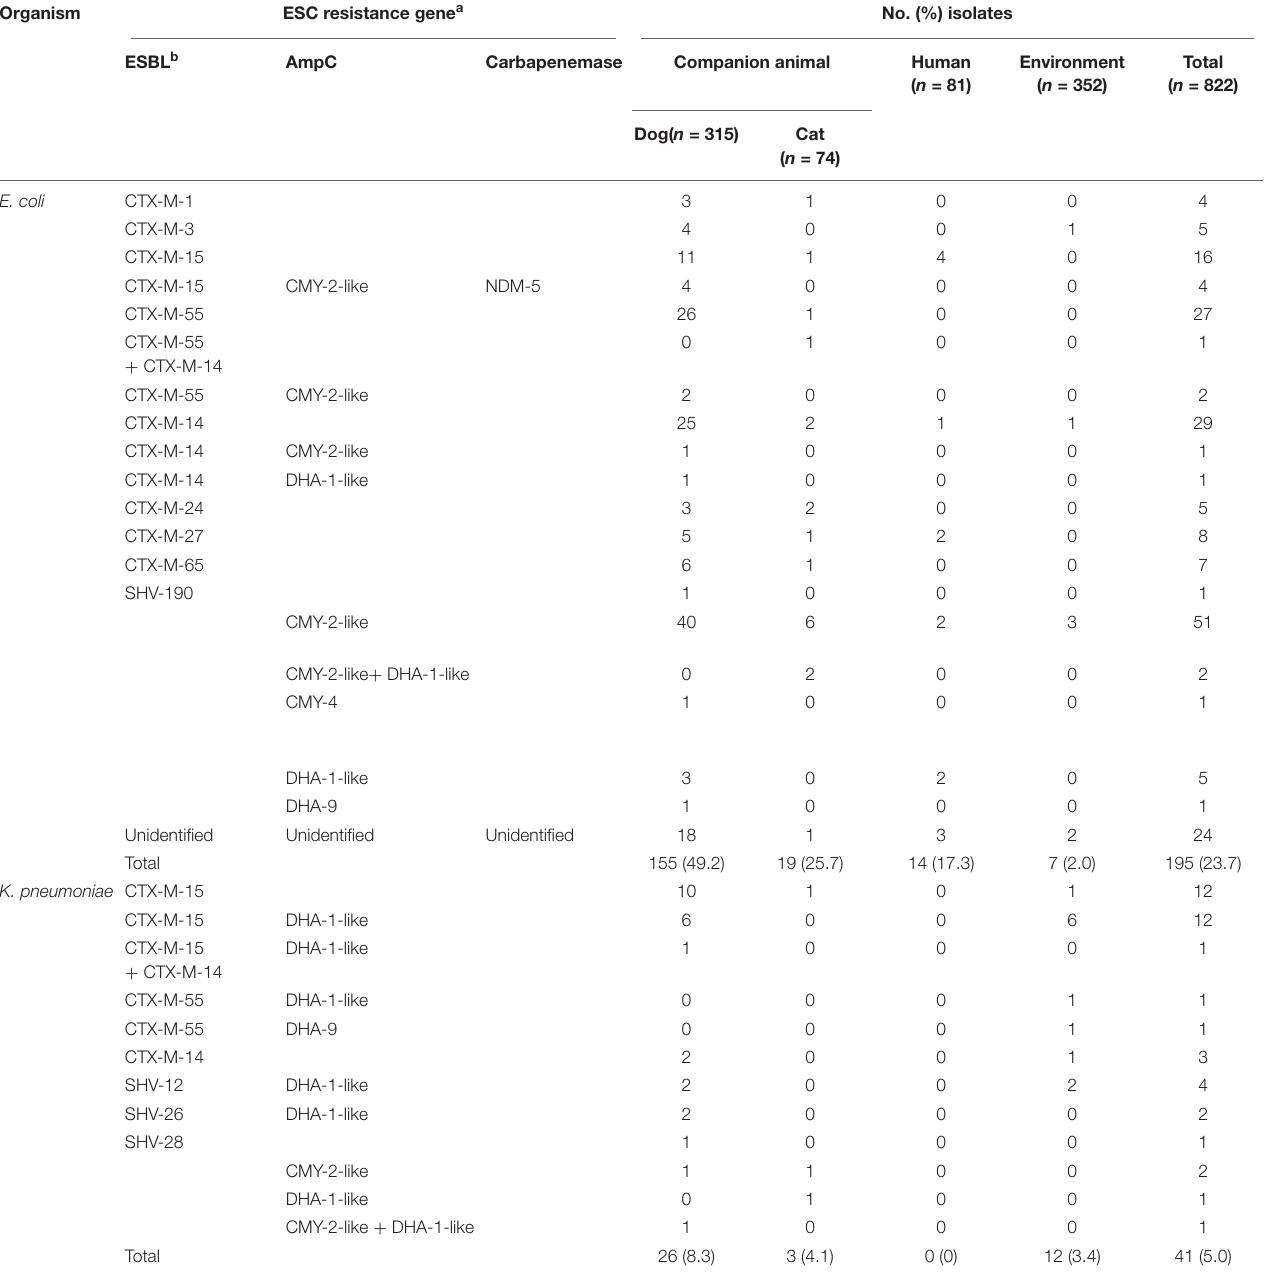
TABLE 1 | Genotypes of β -lactamases in extended-spectrum cephalosporin-resistant E. coli and K. pneumoniae isolates from companion animals, humans, and the hospital environment.